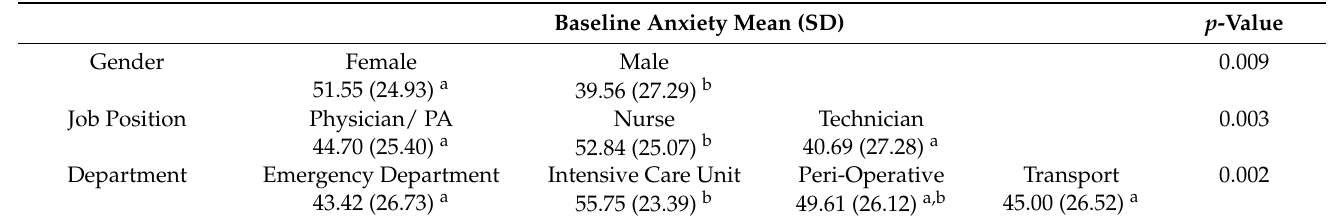
Table 2. Baseline COVID anxiety across healthcare worker demographic groups.